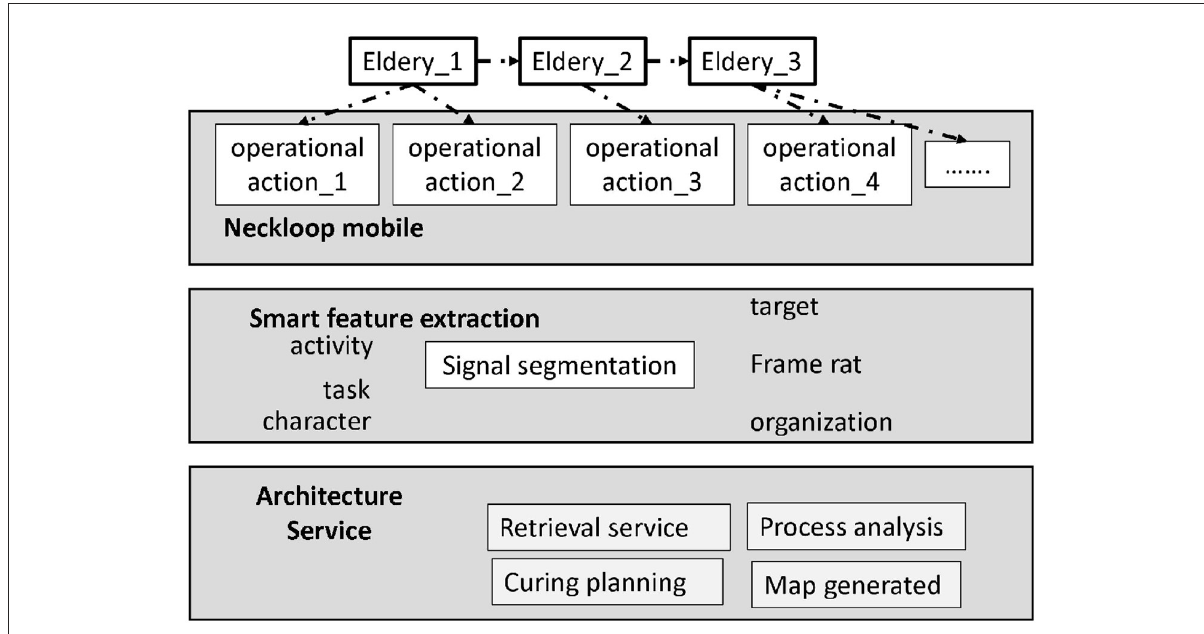
FIGURE1 Community-based elderly care service model for the elderly who have lost their